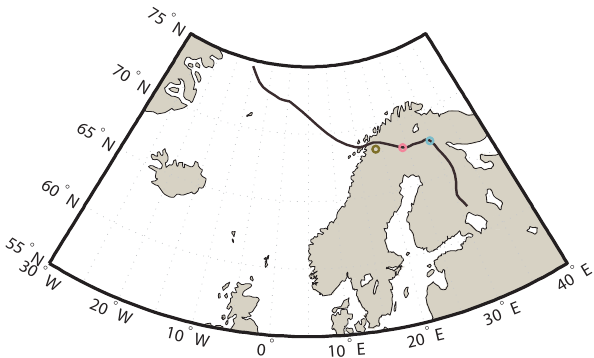
Figure 1. The studied air-mass trajectory retrieved from the HYS- PLIT model. The brown, pink and blue circles display the location of the measurement stations Abisko, Pallas and Värriö, respectively.